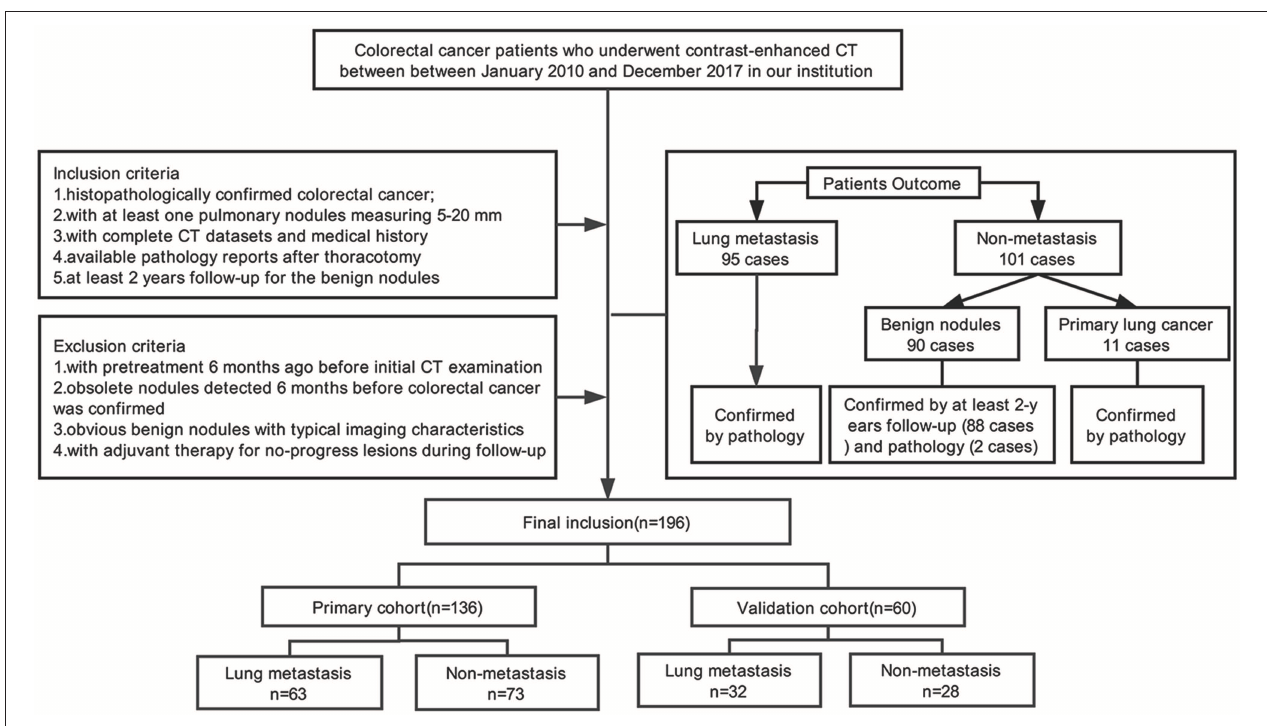
FIGURE 1 | Flow chat of patients’ recruitment pathway.